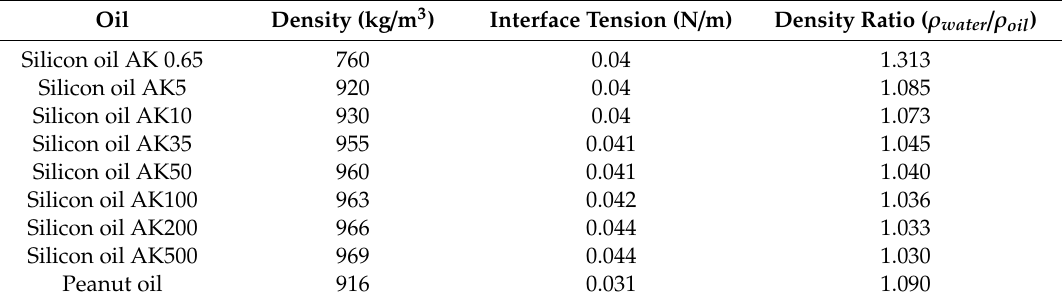
Table 2. Properties of di ff erent oils [15,27].